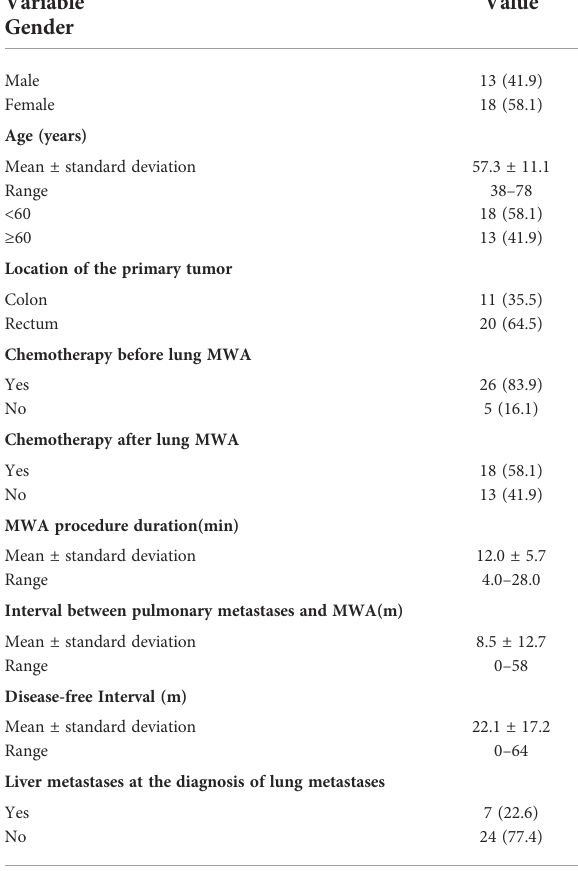
TABLE 1 Baseline characteristics of patients.